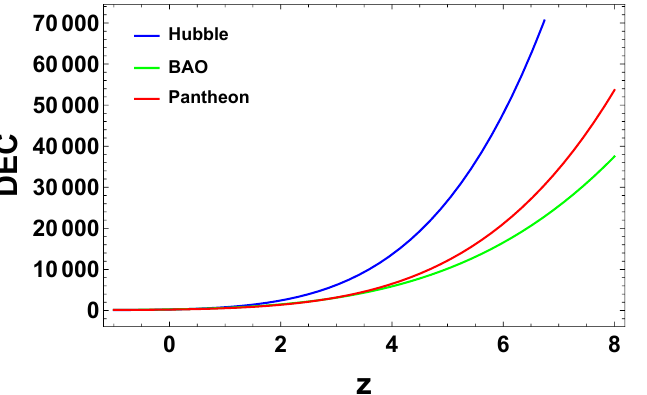
Figure 9. Profile of the null energy condition for the given model corresponding to the values of the parameters constrained by the Hubble, BAO, and Pantheon data point sets.